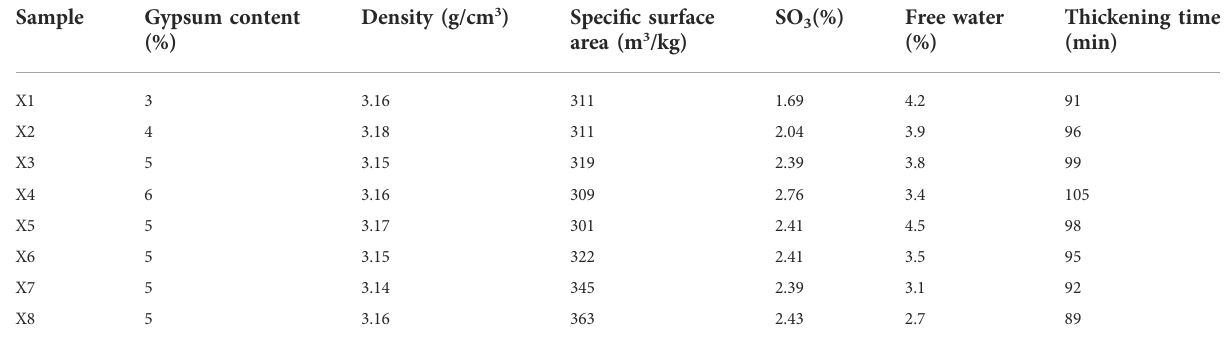
TABLE 8 The in fl uence of different SO 3 contents on cement performance.